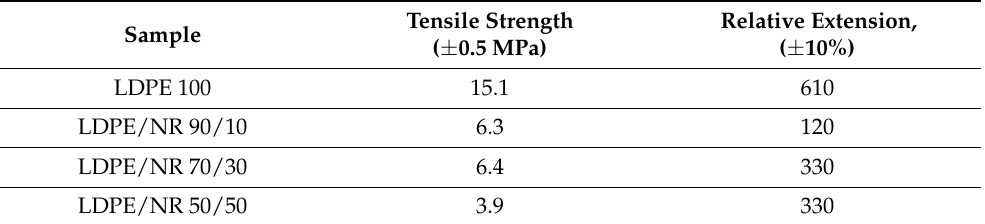
Table 3. Average values of the characteristics of the non-woven materials based on LDPE with different content of